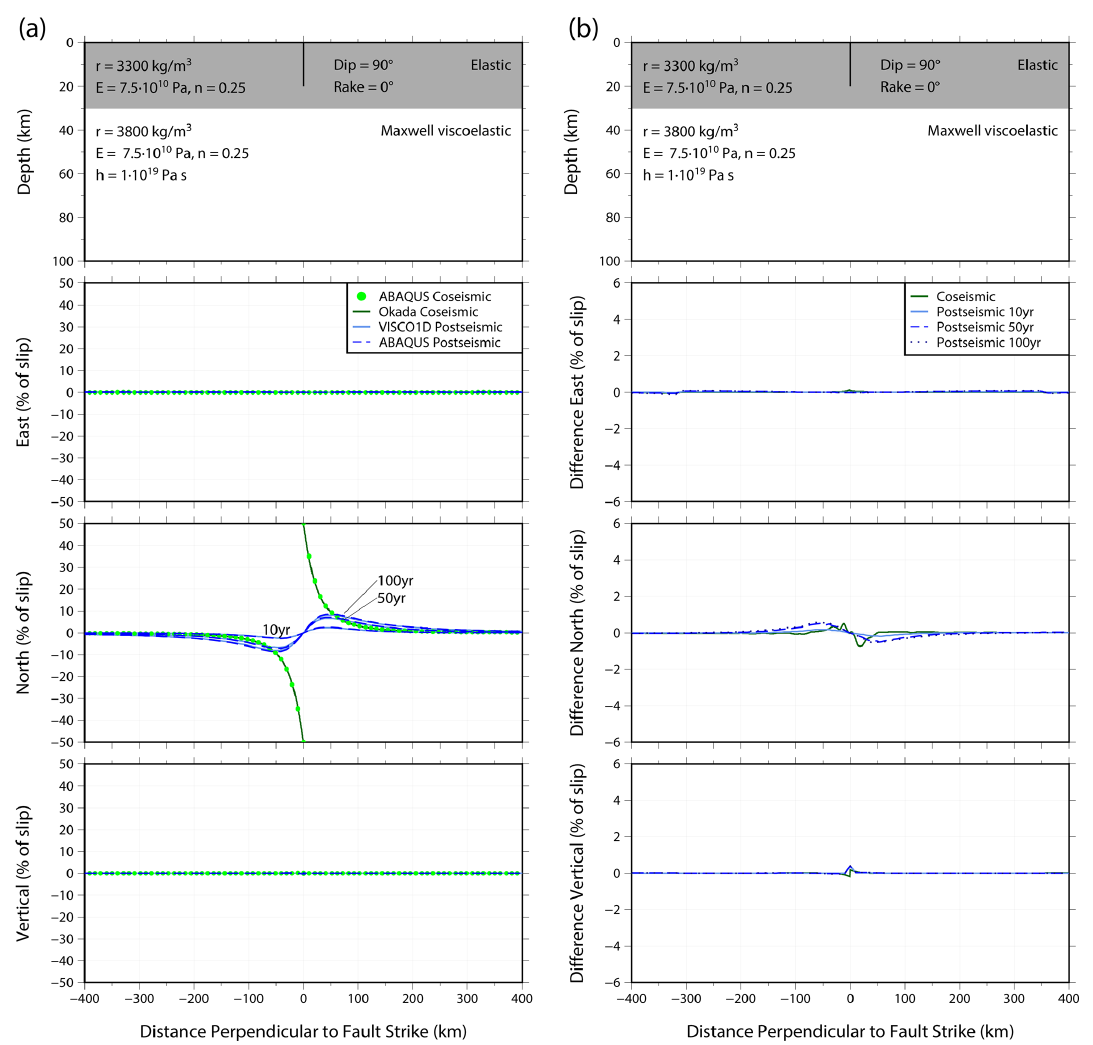
Figure 3. Top panels of (a) and (b) show the fault dimensions and material properties of the upper 100km of the model. Layers and material properties below 100km depth are given in Table 2. (a) Coseismic (green) and post-seismic (blue) surface displacements in the east, north and vertical directions in response to slip on a strike-slip fault for a profile perpendicular to the fault strike. Results are calculated using the Okada analytical solution, VISCO1D and Abaqus (see legend). Post-seismic displacement is shown for times 10, 50, and 100 years after fault slip. Earth properties and fault dimension are given in top panel. Displacements are given as a percentage of the fault slip. (b) Differences between the Abaqus coseismic displacement and the Okada analytical solution (green) and the Abaqus post-seismic displacement and the VISCO1D displacement (blue). Differences are in terms of percentage of the fault